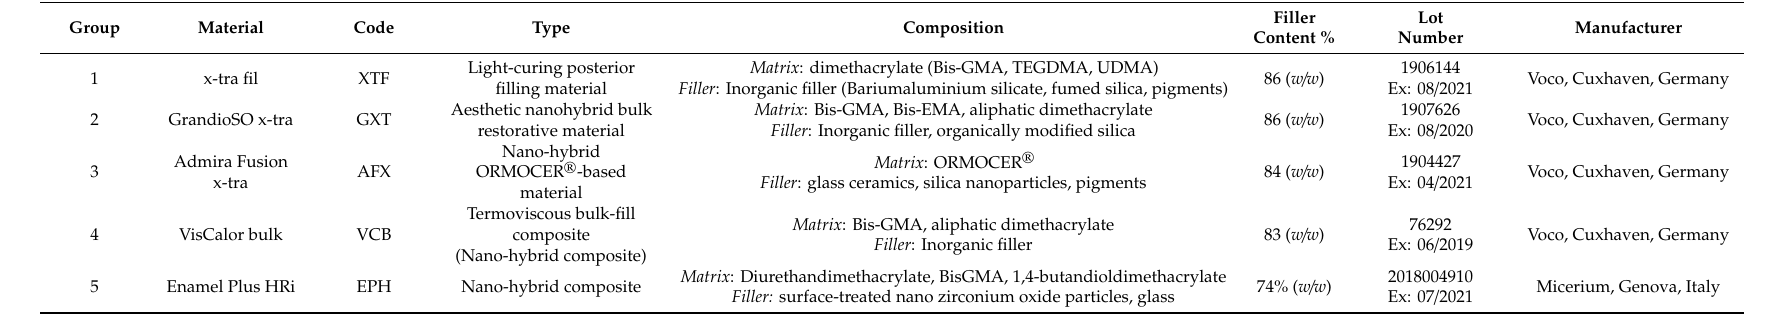
Table 1. Characteristics of the materials